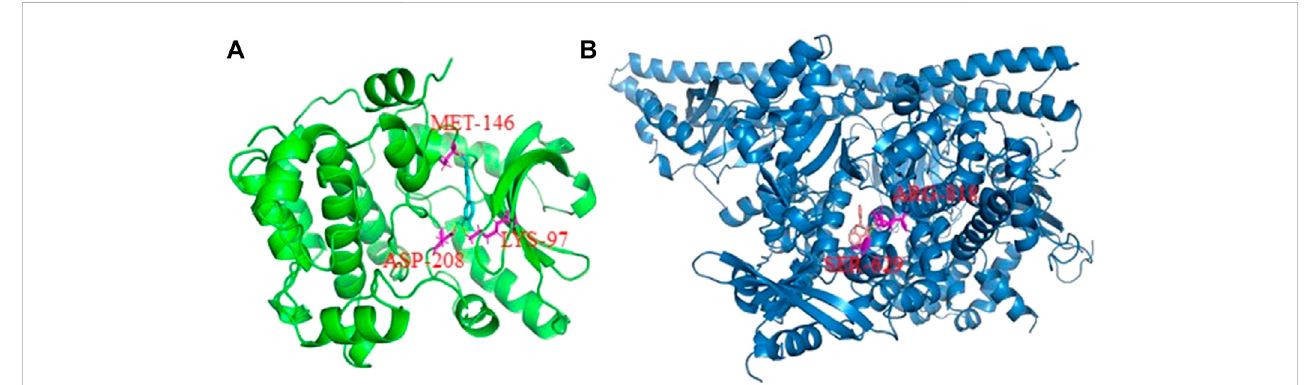
FIGURE 6 The three-dimensional cartoon display of interactions between active compounds and target receptors. (A) MAP2K1 protein with luteolin; (B) PIK3CA protein with 3-hydroxy fl avone. The amino acid residues which connected with the active compounds with hydron bond were shown in